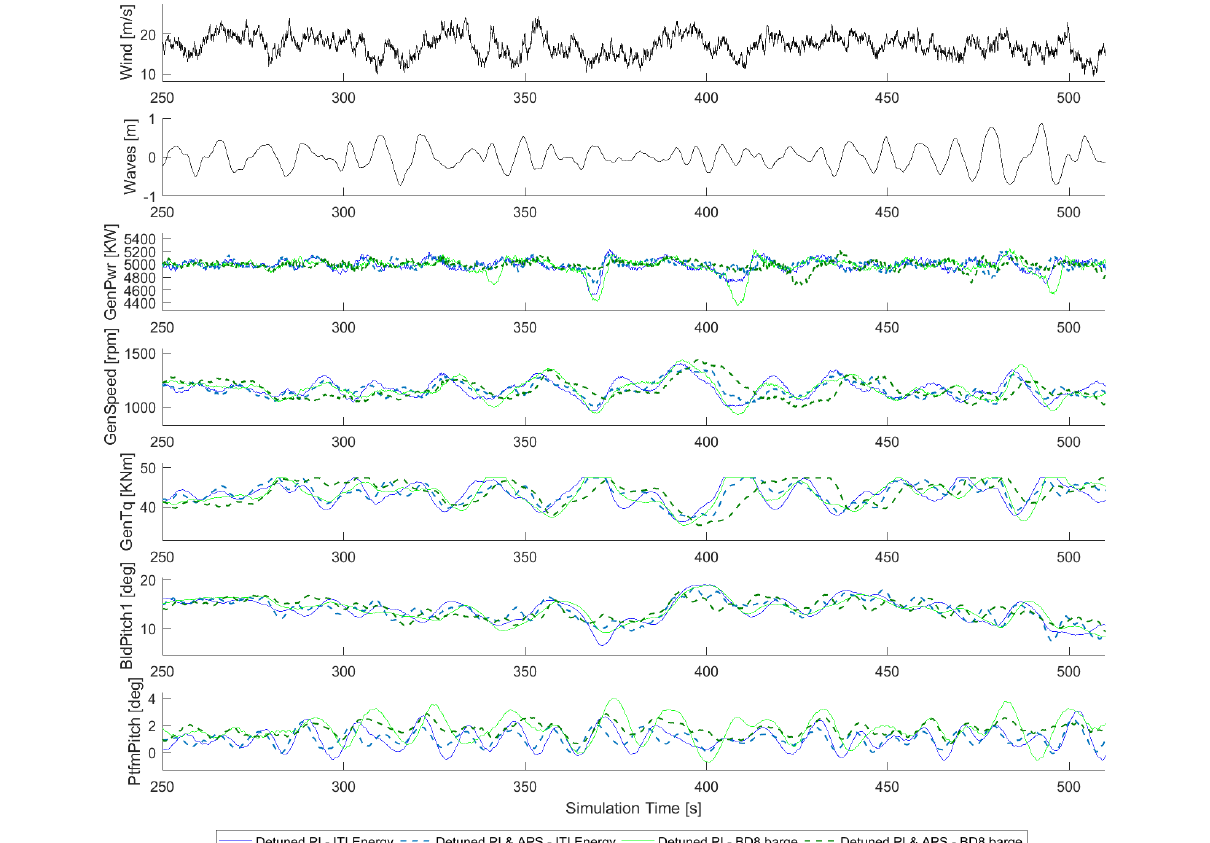
Figure 8. Time domain FOWT systems’ simulations at 17 m/s mean wind speed and 1.37 m of